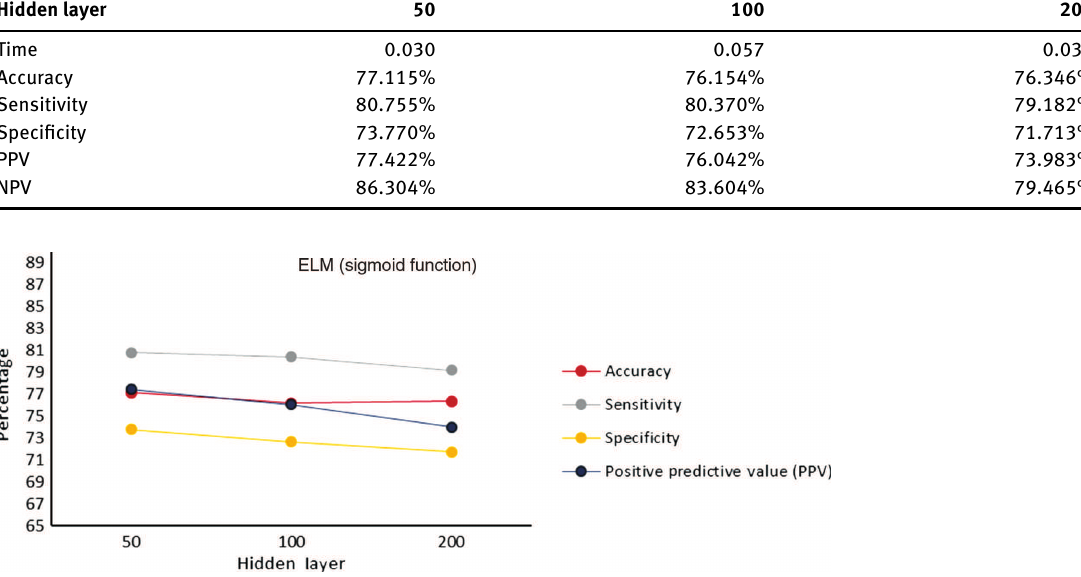
Figure 5: ELM Statistical Performance Measures Plotting (Sigmoid Function). Table 2: Extreme Learning Machine Using Sine Function Result.